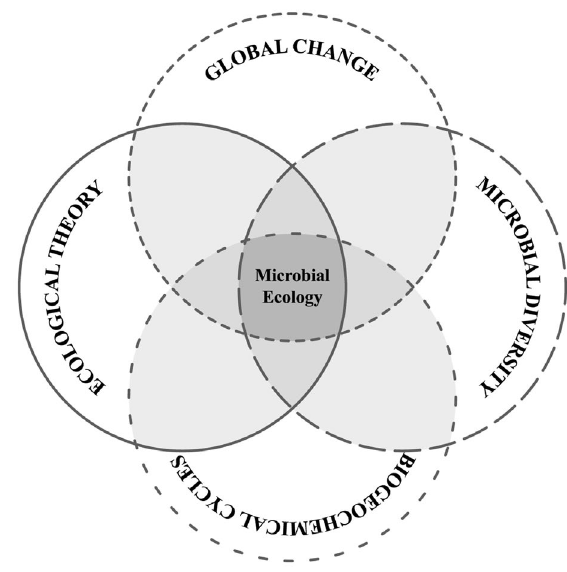
Fig. 1. – The integrated approach to aquatic microbial ecology inspired by the Margalef